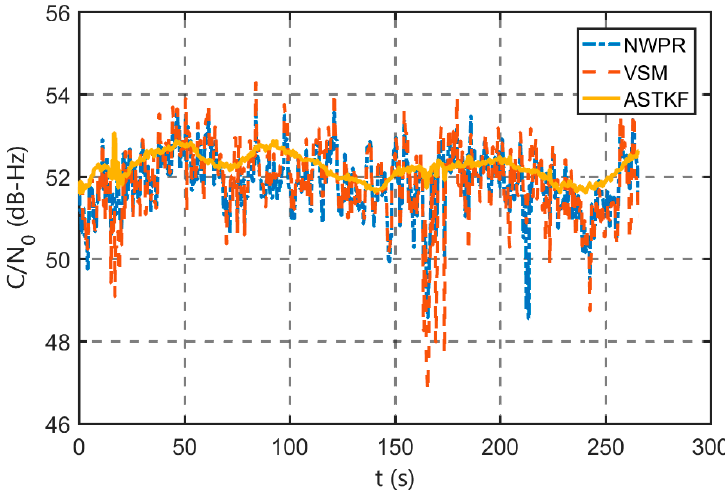
Figure 11. Satellite 10 C/N 0 (0.5 s averaging time).